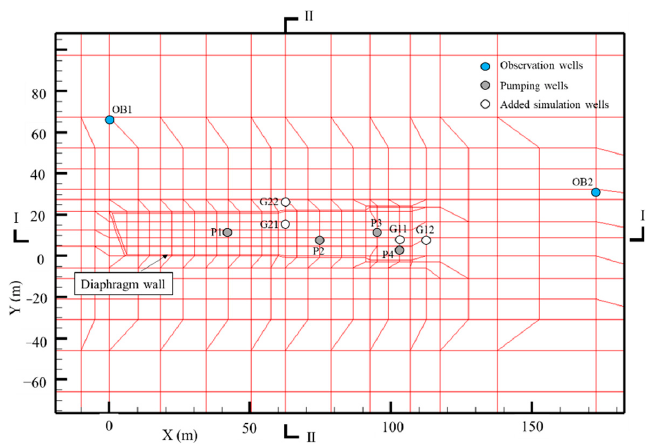
Figure 5. Plan view of local enlarged mesh inside foundation pit.